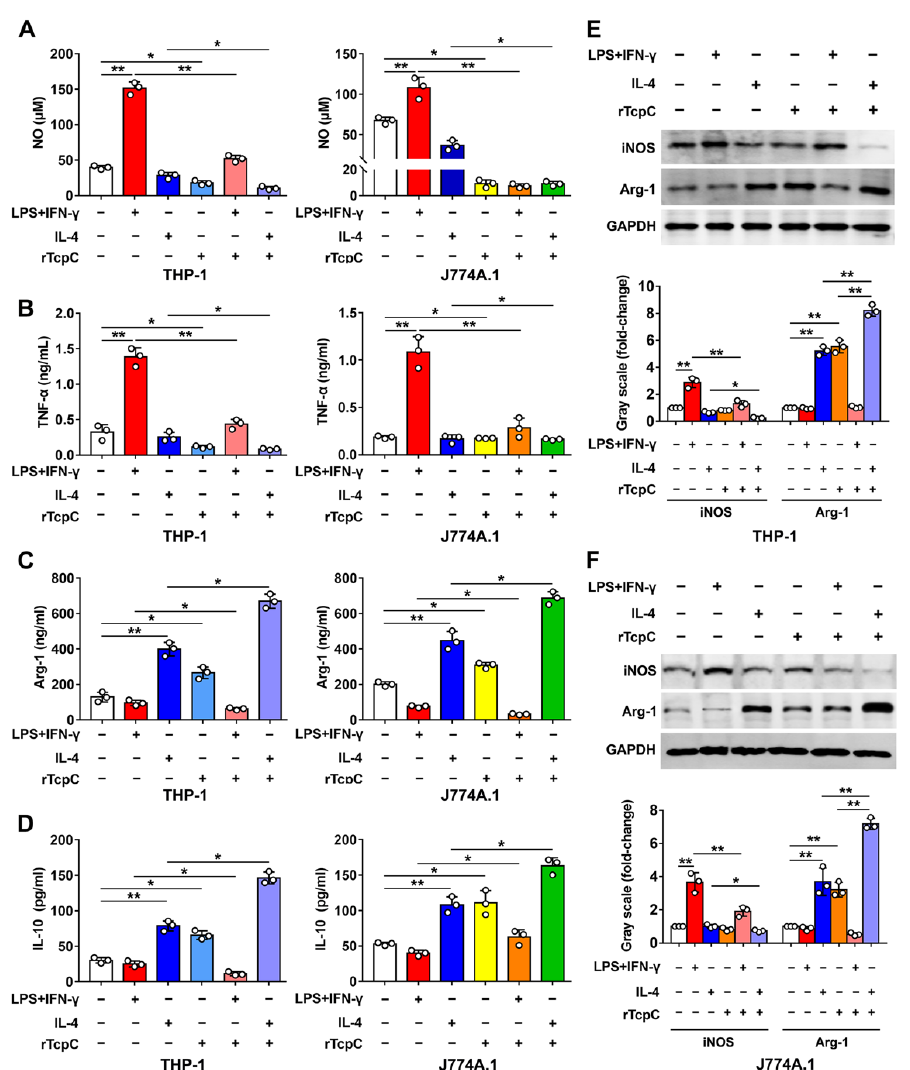
Figure 5. rTcpC suppresses the expression of proinflammatory factors and iNOS, but enhances the production of IL-10 and Arg-1 in macrophages. ( A ) The influences of rTcpC on NO in THP-1 and J774A.1 were detected by Griess method. ( B – D ) The expression levels of TNF- α , Arg-1 and IL-10 in THP-1 and J774A.1 were detected by ELISA. ( E , F ) The expression levels of iNOS and Arg-1 and bands ’ gray-scale analyses in THP-1 and J774A.1, respectively. Gray scale in the control group was set as 1.0, Mean ± SD of three independent experiments are shown. * : p < 0.05; ** : p < 0.01.